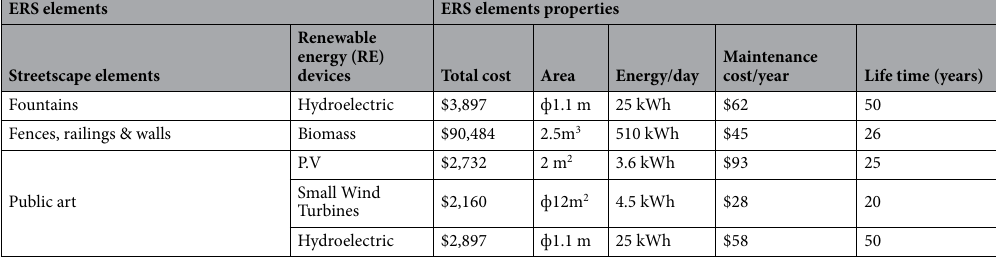
Table 4. Properties of energy-RoadScape elements ERS